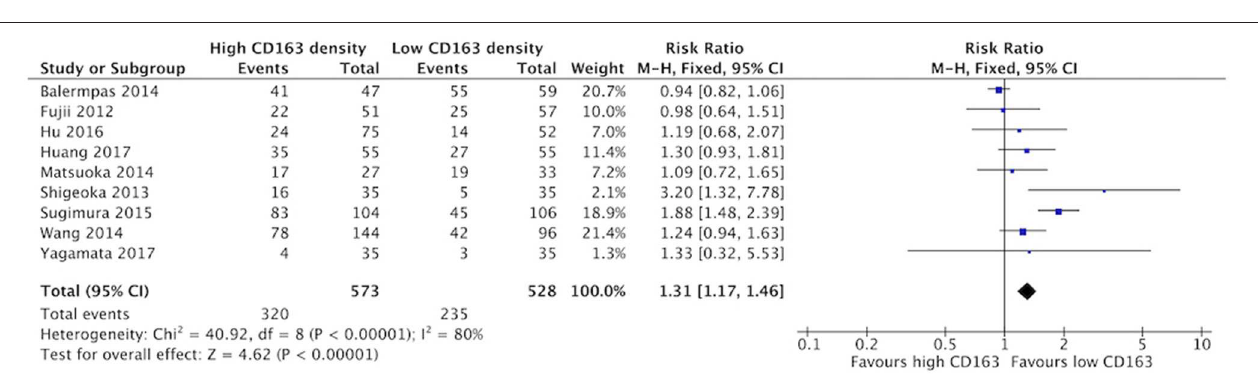
( Figure 1 ). All immunohistochemistry was performed on tumor samples from patients with HNSCC. A total of 1,551